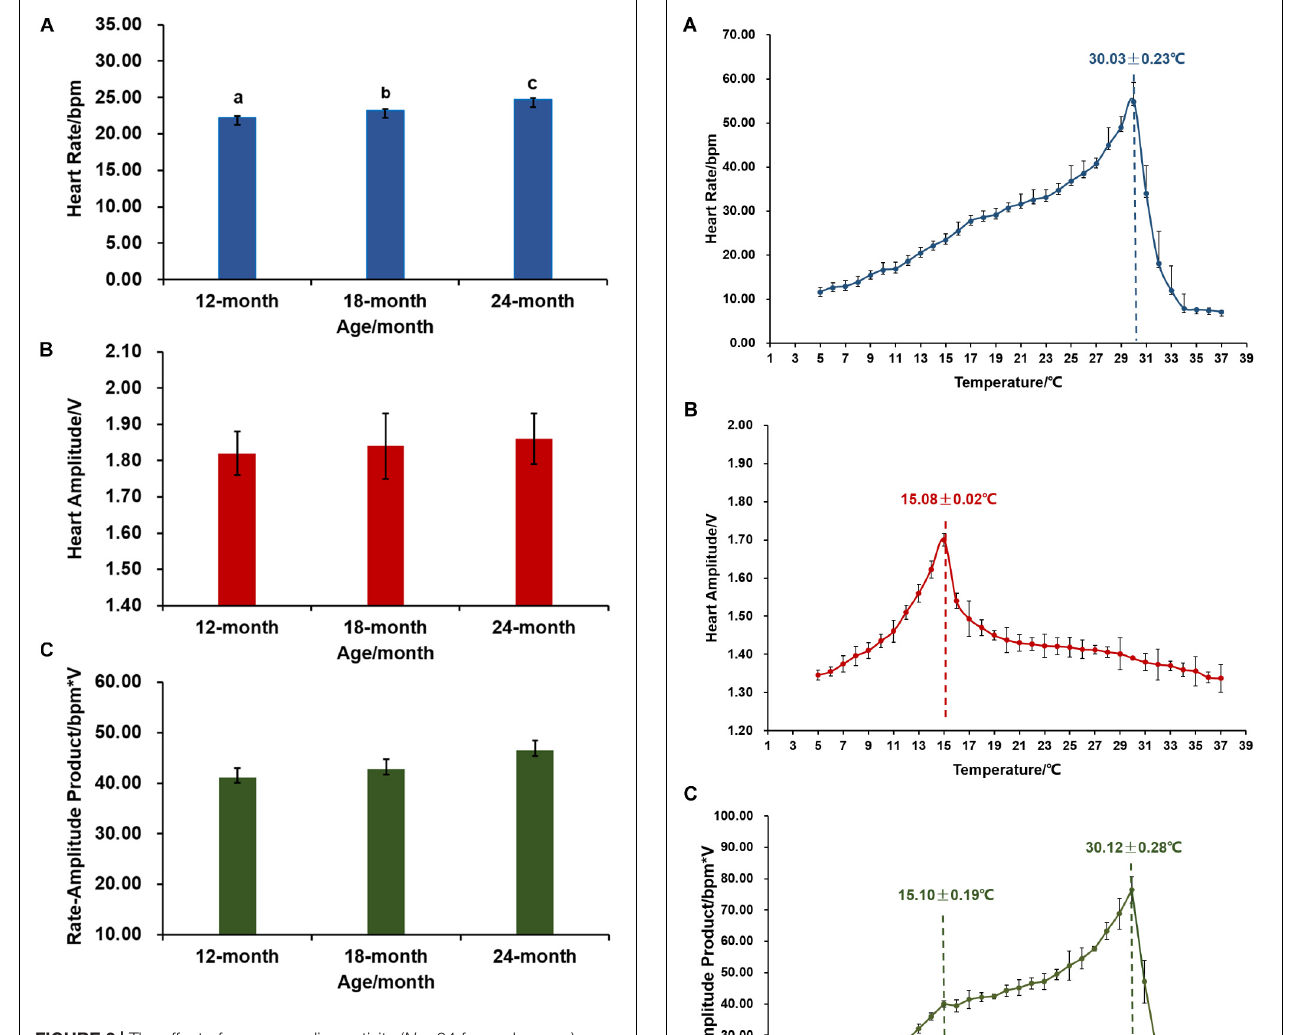
FIGURE 2 | The effect of age on cardiac activity ( N = 24 for each group). (A) HR of Zhikong scallops with different ages. Different letters indicate significant differences ( P < 0.05). (B) HA of Zhikong scallops with different ages. (C) RAP of Zhikong scallops with different ages.